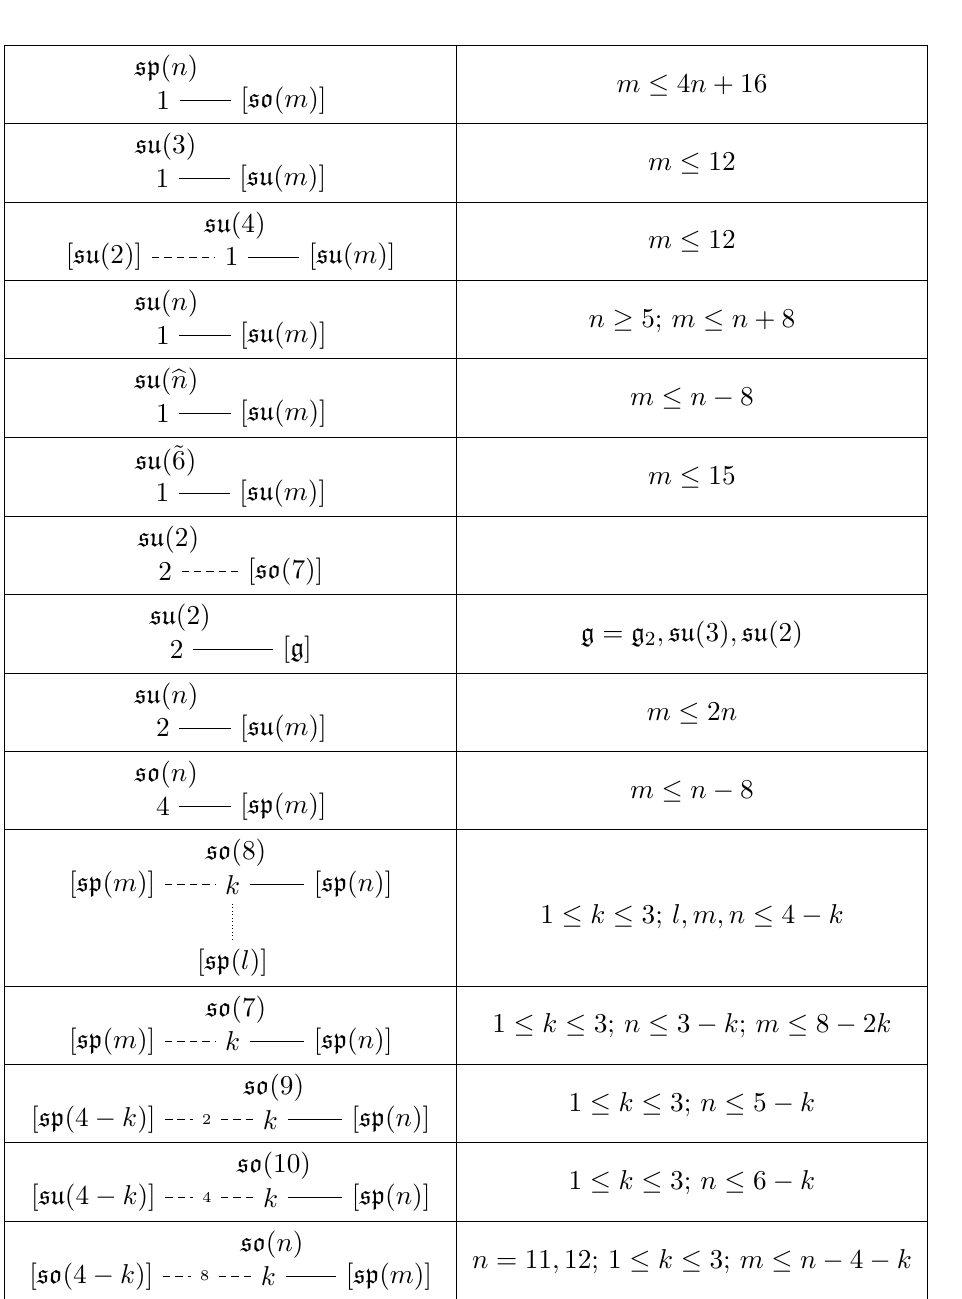
Table 1 . The possible localized flavor symmetries in the context of 6 d SCFTs. See the text for more explanation. Continued in table